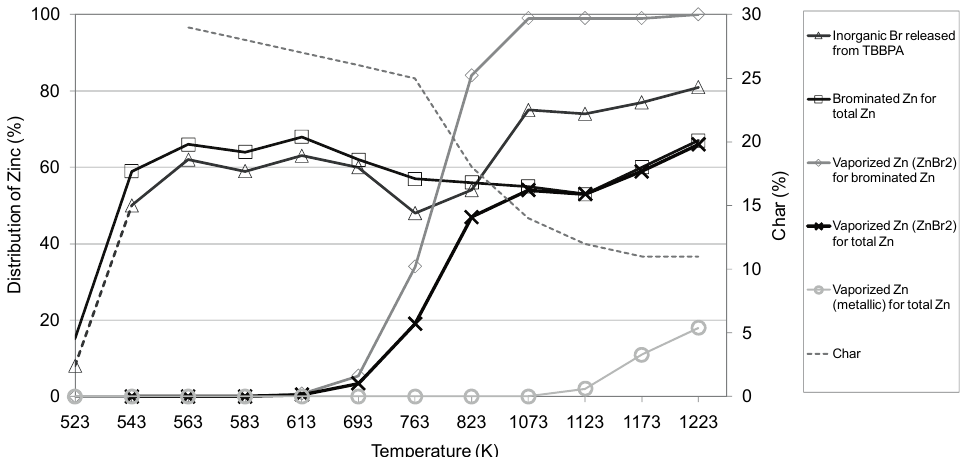
Figure 3. Distribution of zinc during isothermal treatment of TBBPA:ZnO (3.34:1) at selected temperatures at Argon atmosphere for 40